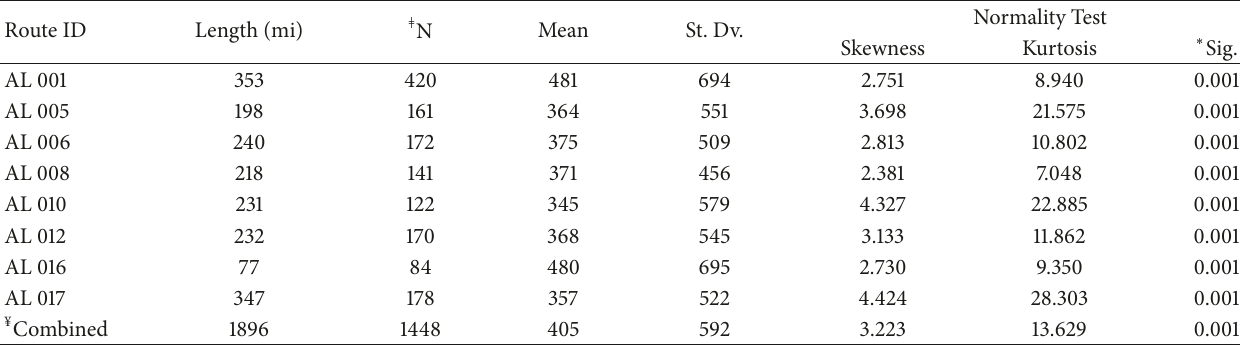
Table 1: Descriptive statistics of the nonsevere crash rates occurring on dry pavement surfaces and tests of normality for the selected eight routes.